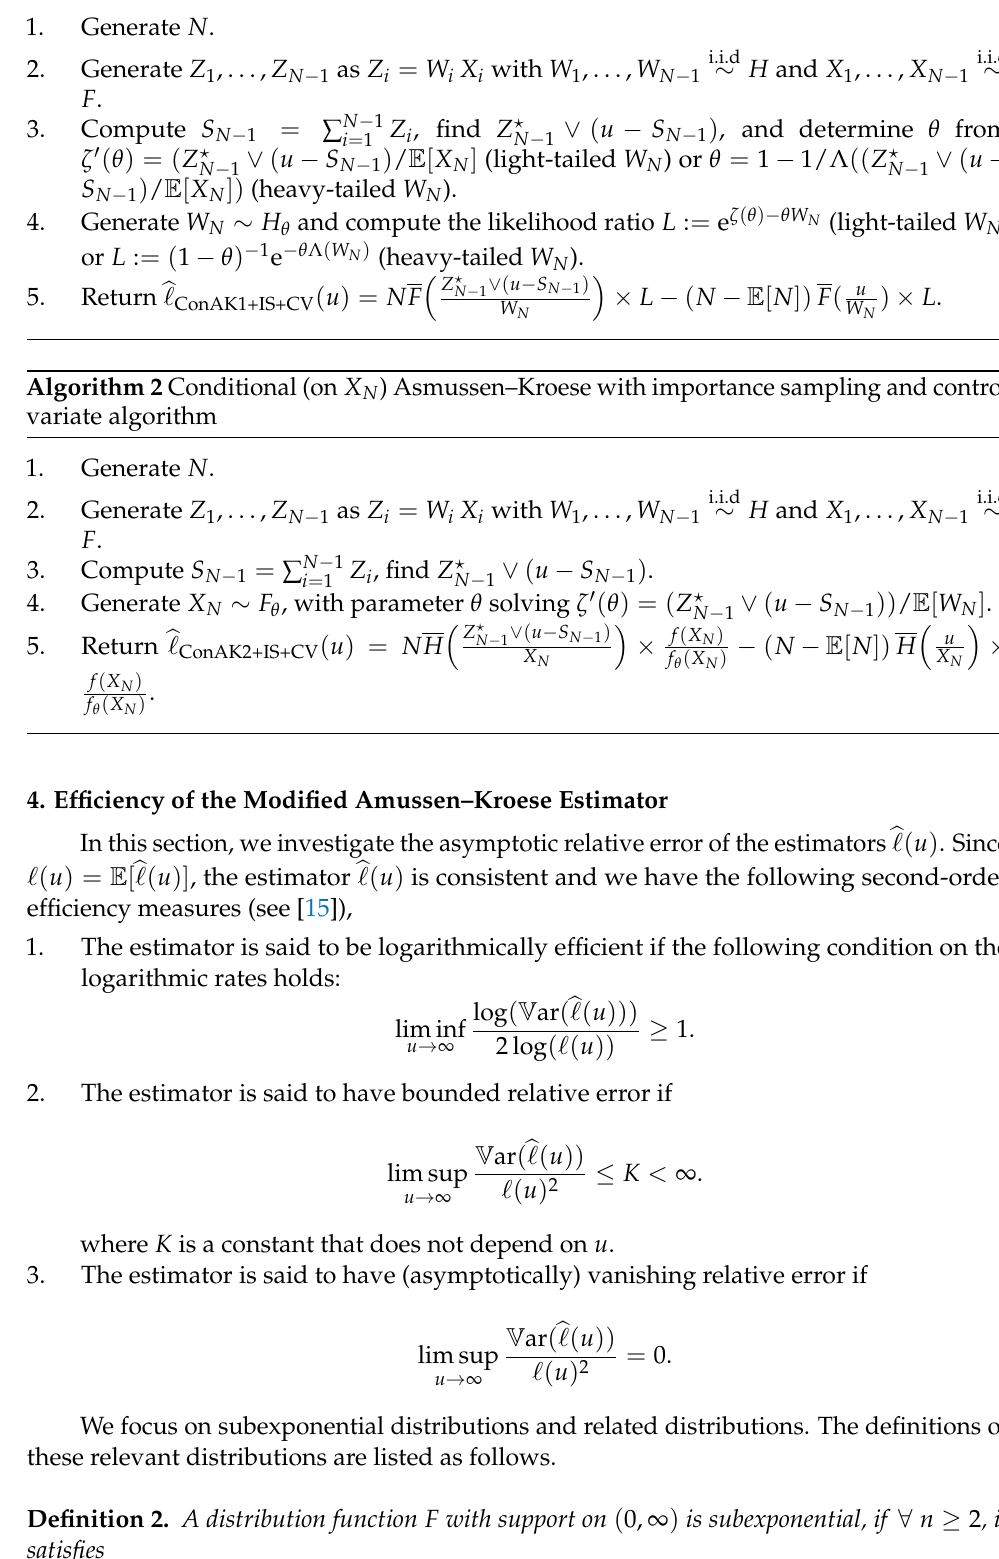
Algorithm 1 Conditional (on W N ) Asmussen–Kroese with importance sampling and control variate algorithm